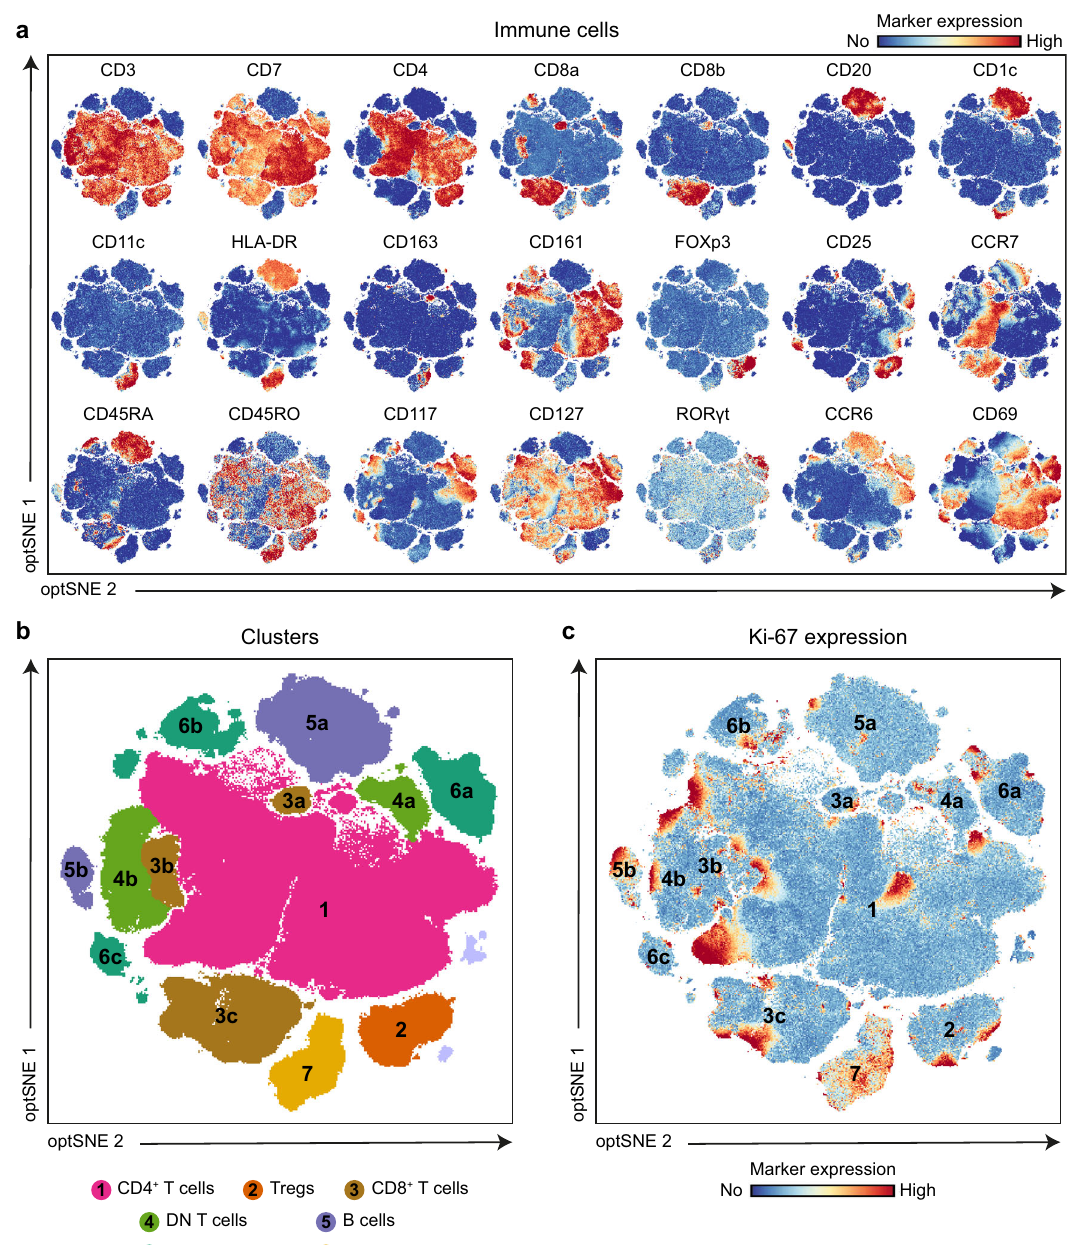
Fig. 1 | Identi fi cation of Ki-67 + cells within all immune subsets in the human fetal intestine. a A collective optSNE was performed on CD45 + immune cells from 12humanfetalintestinalsamples.Eachdotrepresentsasinglecell.Intotal,2.7×10 6 CD45 + immune cells were analyzed by OMIQ. Colors represent relative expression